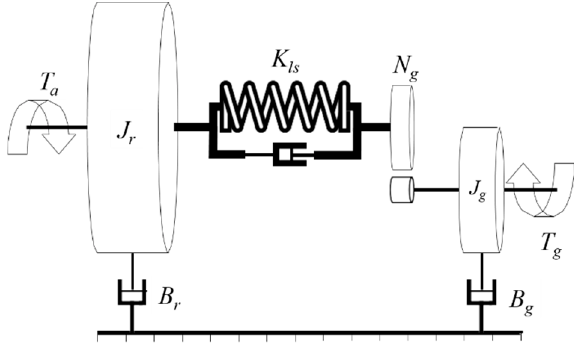
Figure 1. Two-mass flexible shaft drive train model.